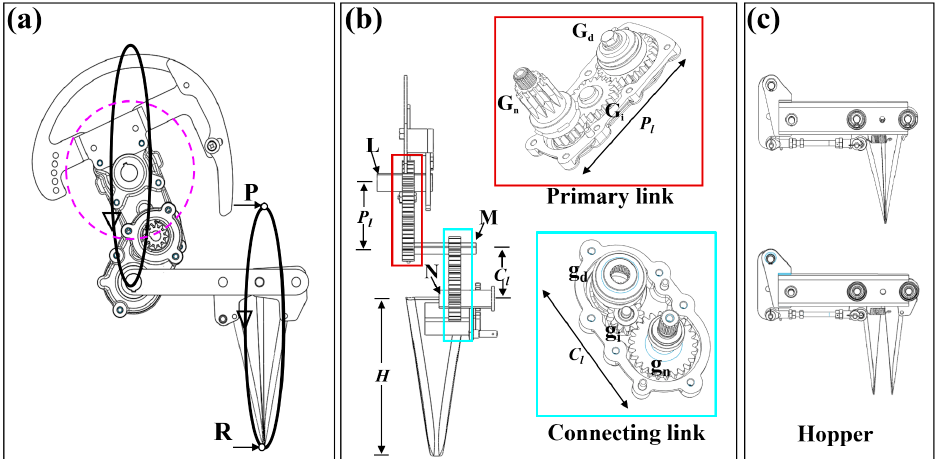
Figure 2. Structure and operational trajectory of the planting mechanism: ( a ) working trajectory of the mechanism, ( b ) primary and connecting links, and ( c ) hopper of the transplanter.